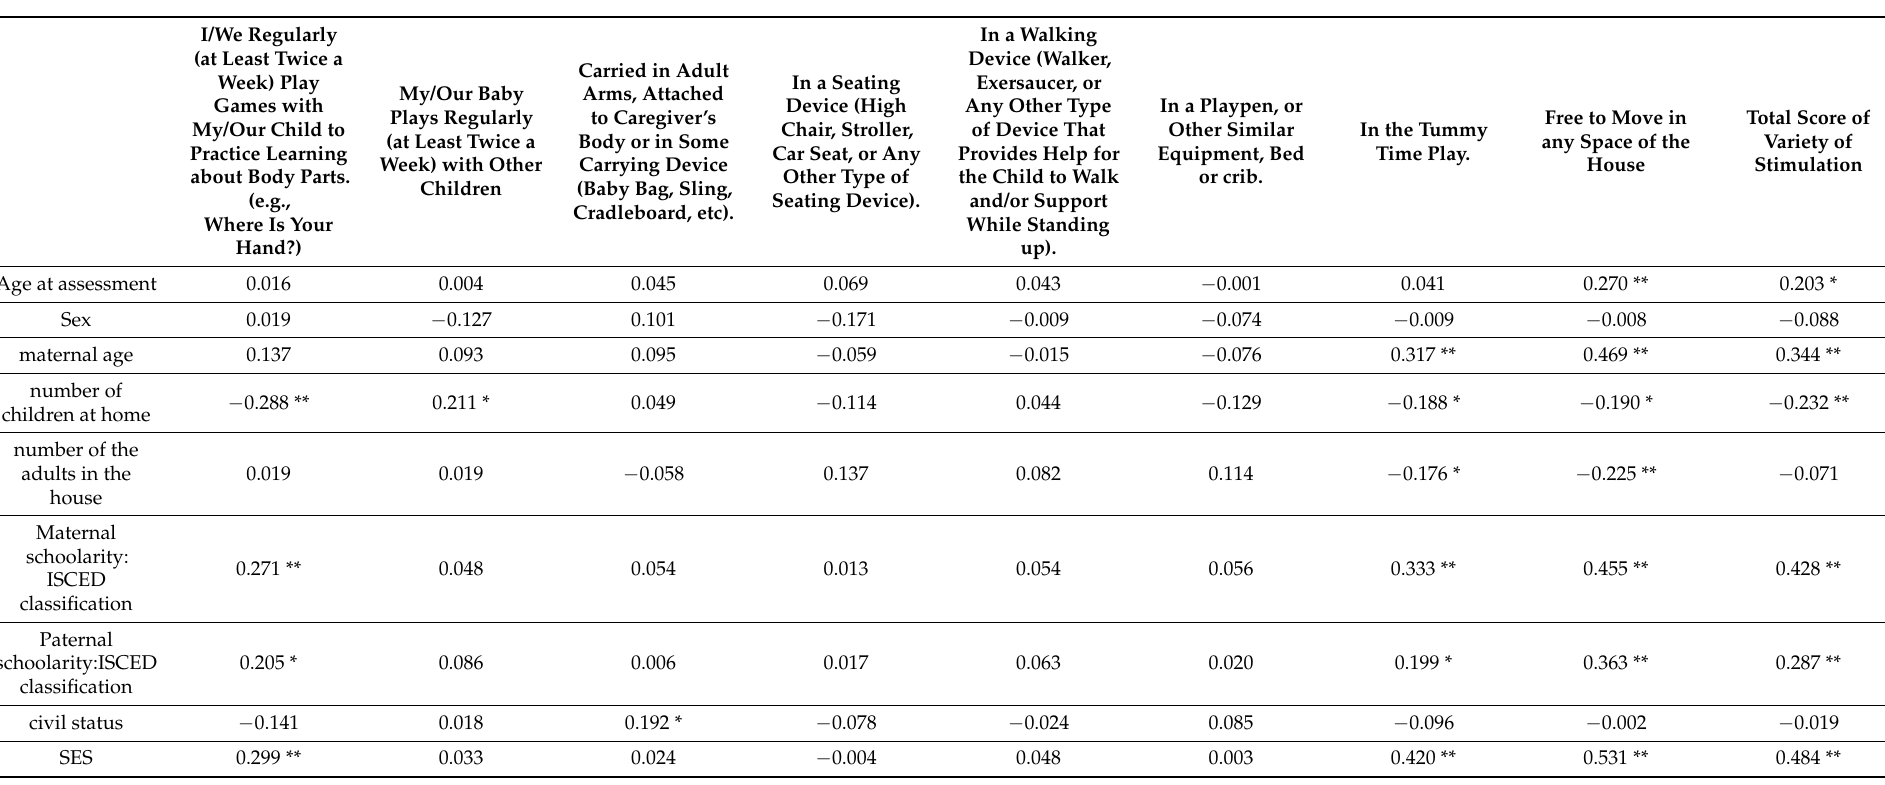
Table 4. Pearson correlation between environmental factors and parental practices versus questions which compose the variety of stimulation dimension from